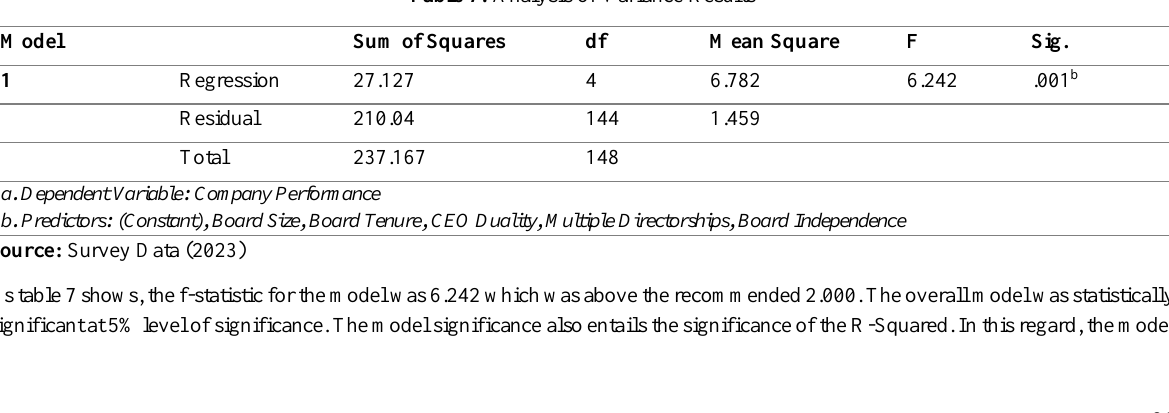
Table 7: Analysis of Variance